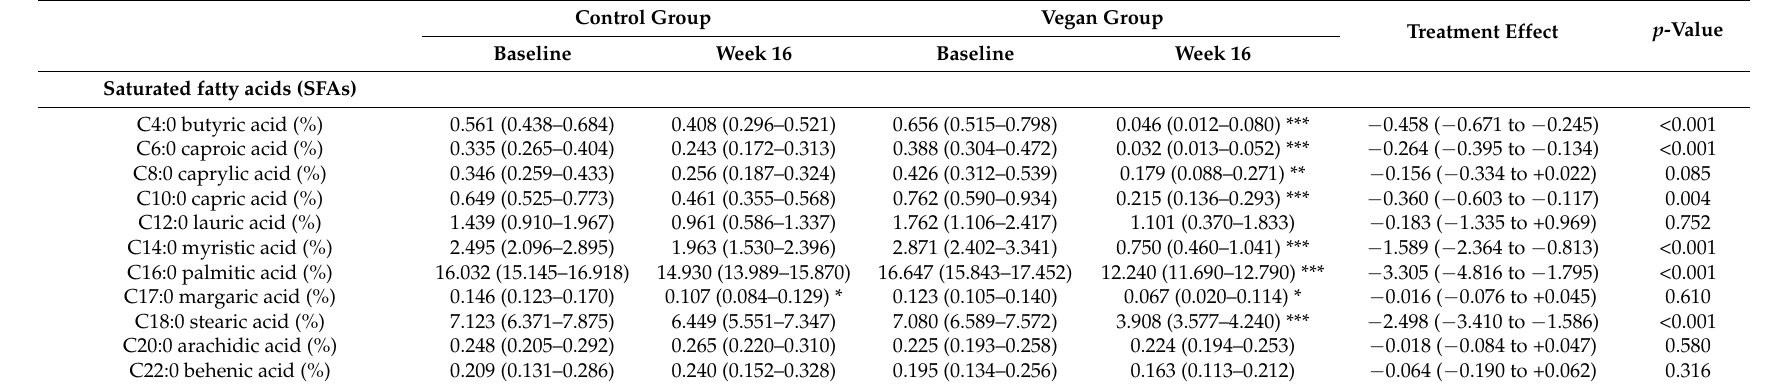
Table 3. Changes in relative dietary intake of Fatty Acids during the study, calculated as percent of total